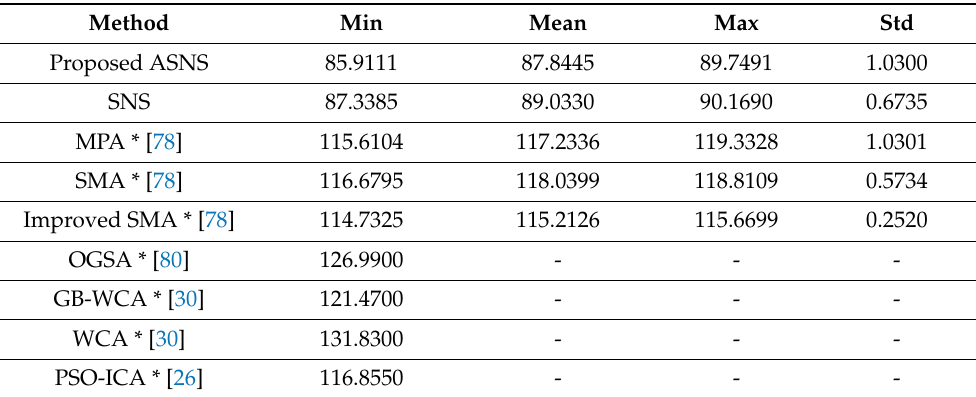
Table 11. Optimal results for Case 2 of the IEEE 118-bus